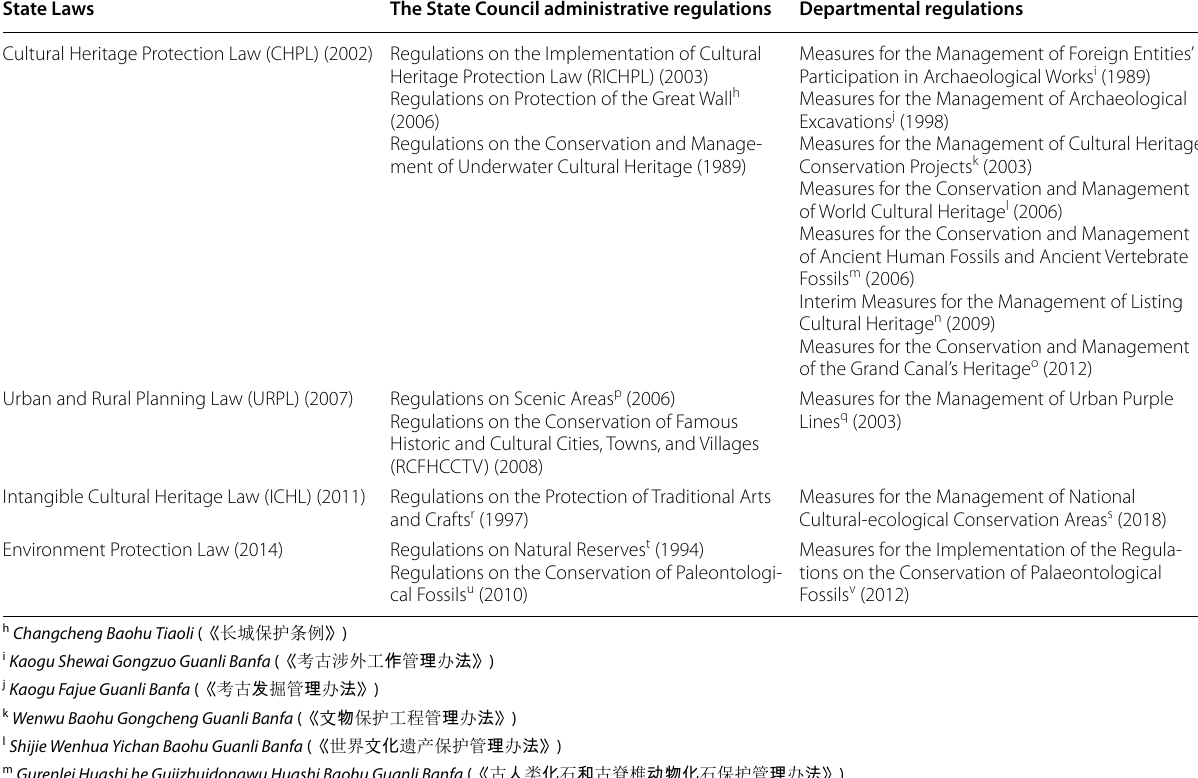
Table 3 List of current state legislation and regulations on cultural heritage